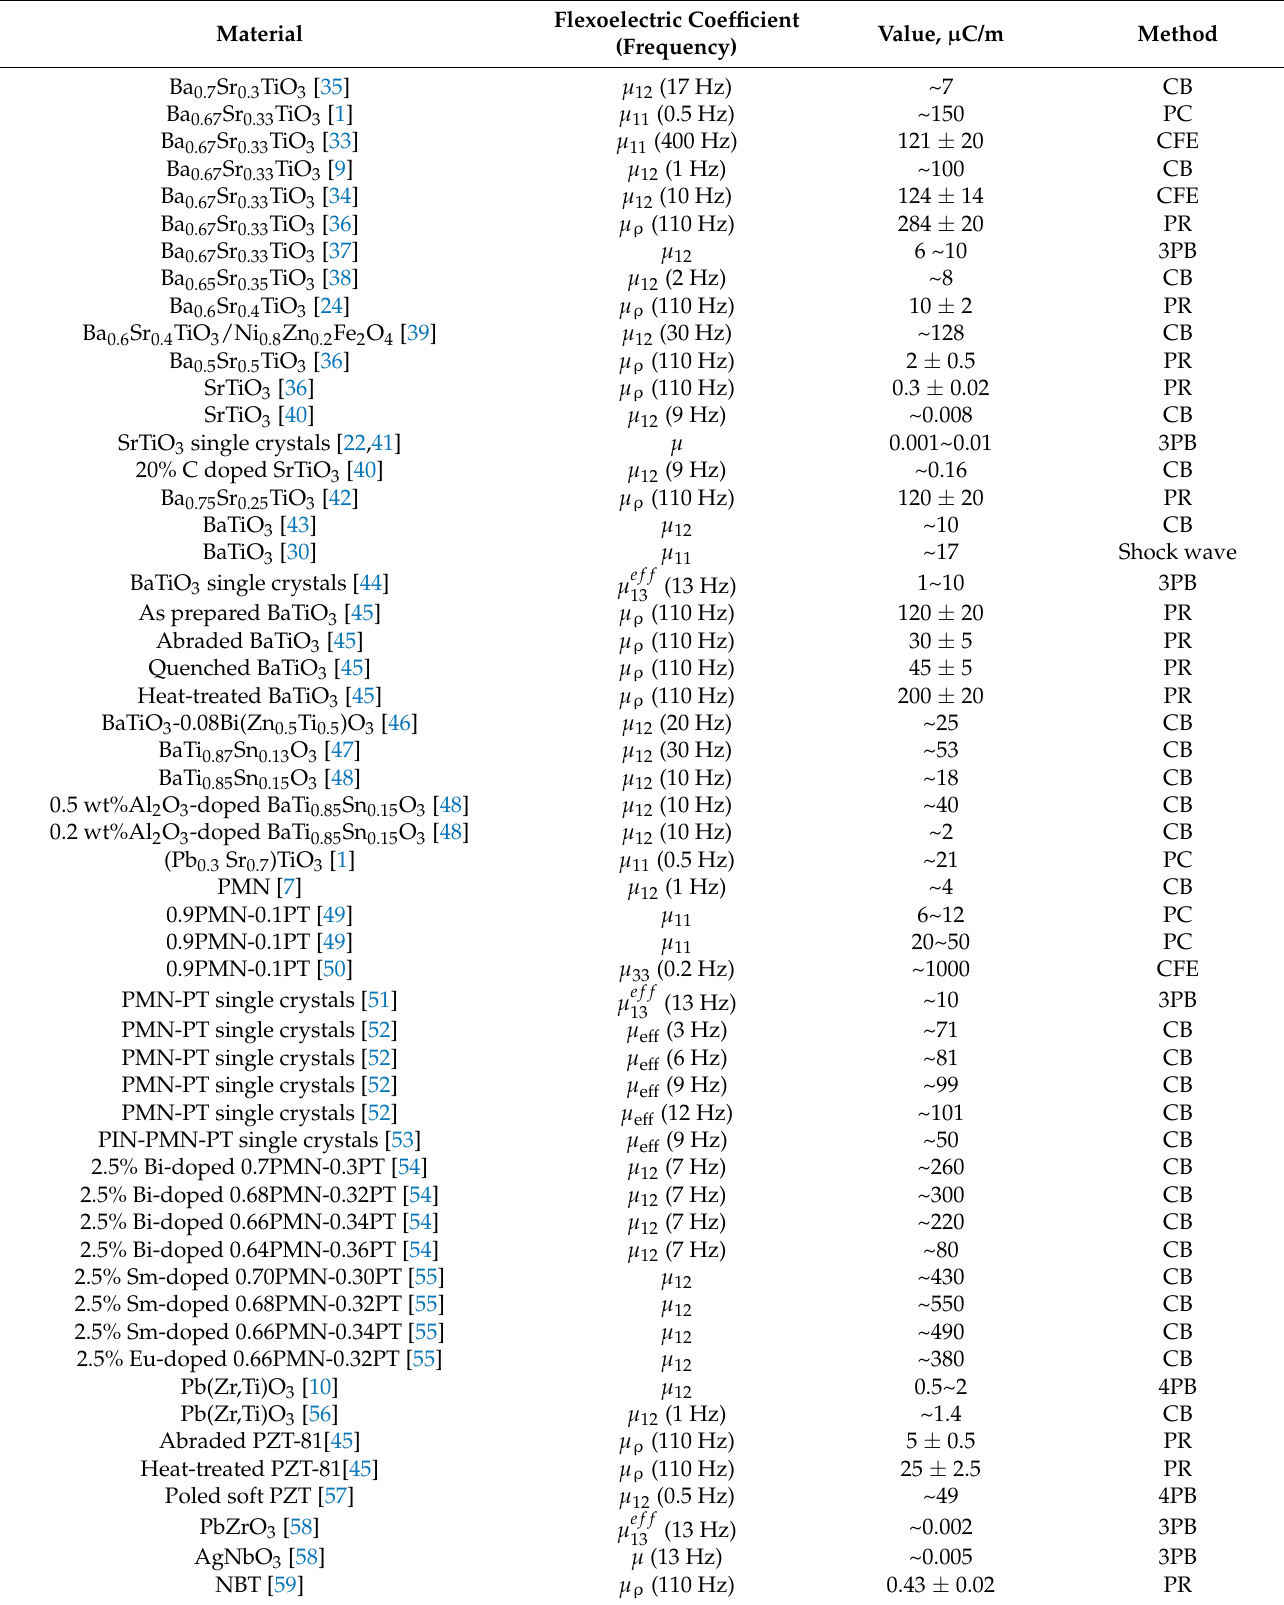
Table 2. Summary of the measured flexoelectric coefficients of inorganic ferroelectric materials at room